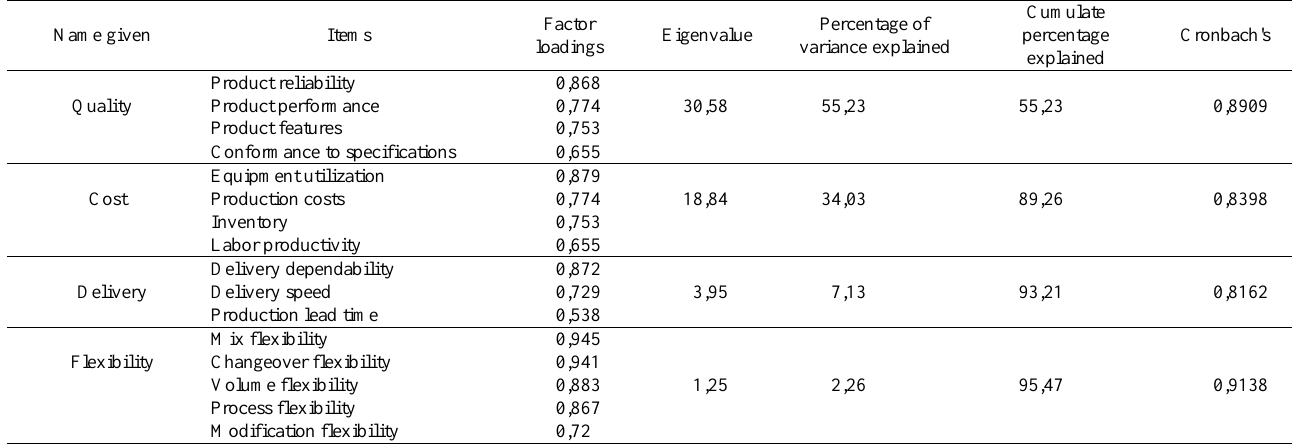
Table 3: Factor analysis of manufacturing performance Name